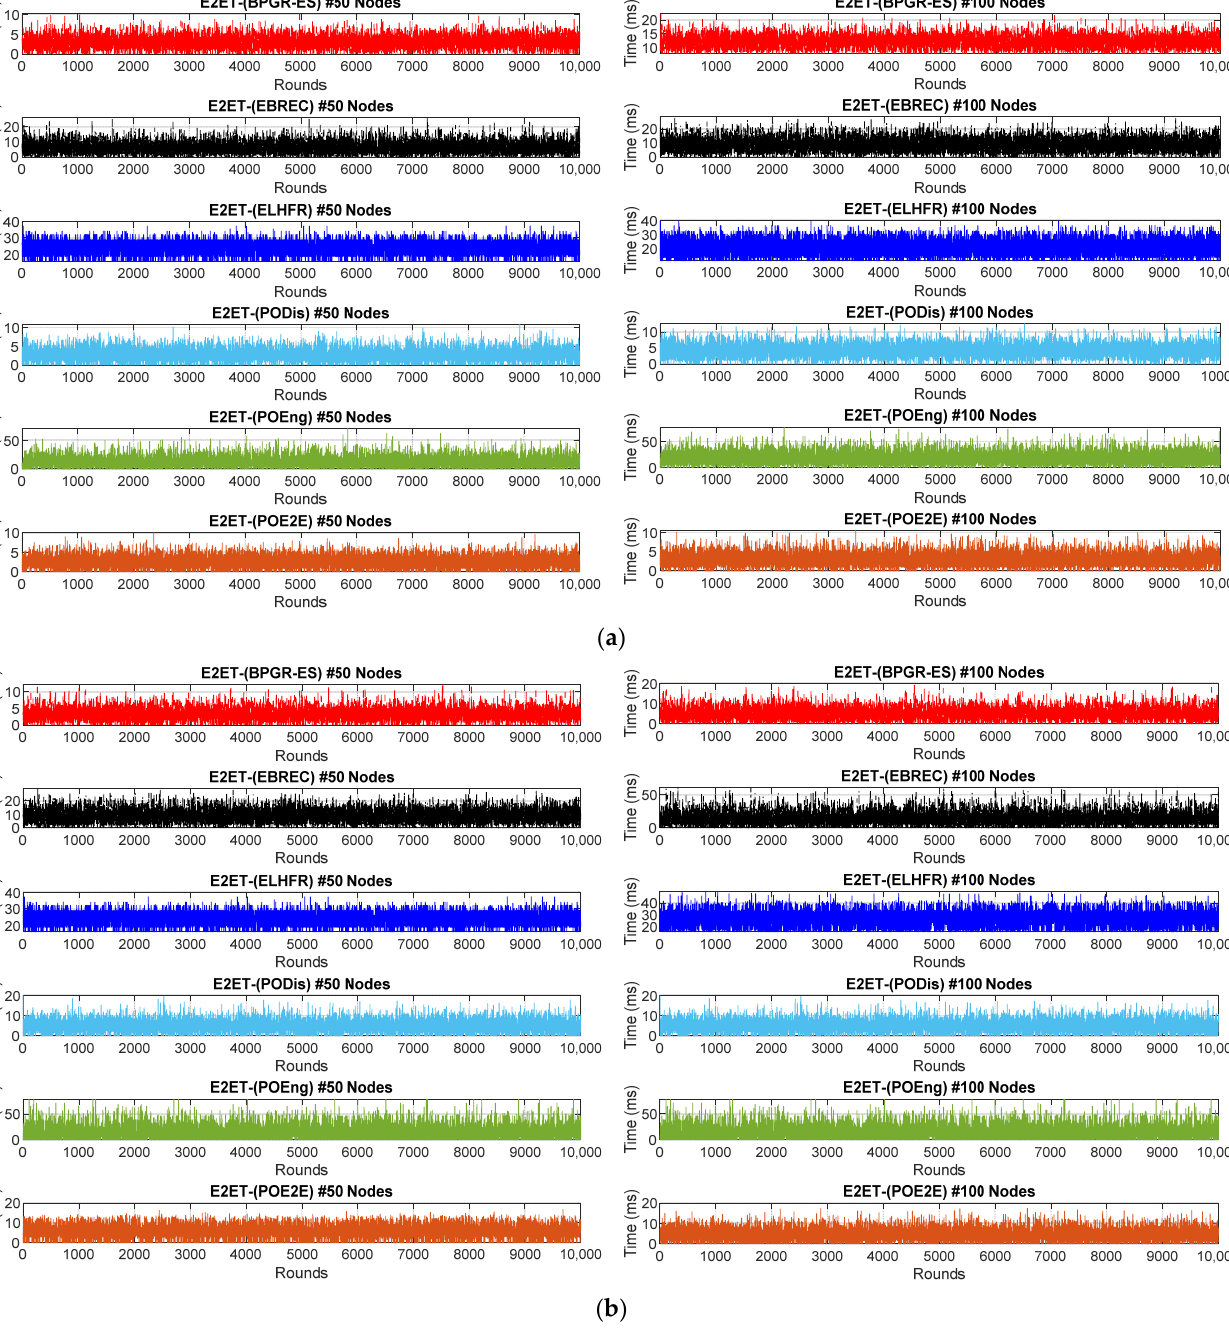
Figure 7. End-to-End transmission time for different topologies: ( a ) E2ET results of 100 × 100 m 2 network area of 50 and 100 sensor nodes; ( b ) E2ET results of 200 × 200 m 2 network area of 50 and 100 sensor